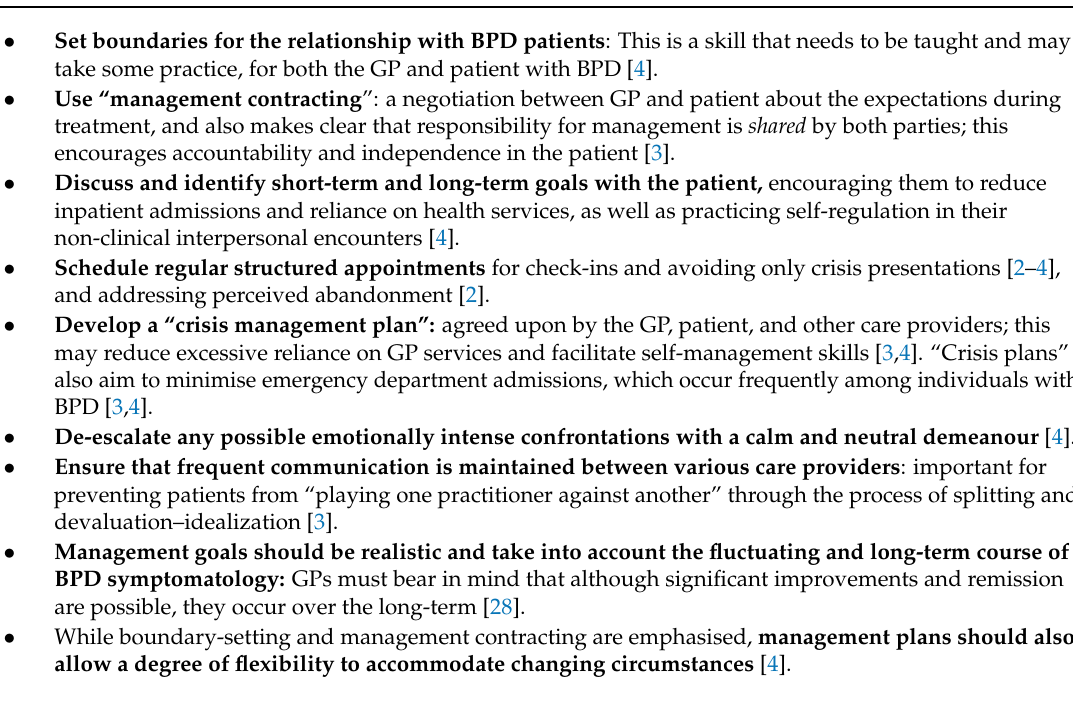
Table 3. Strategies for Managing the GP–BPD Patient Relationship. GP: general